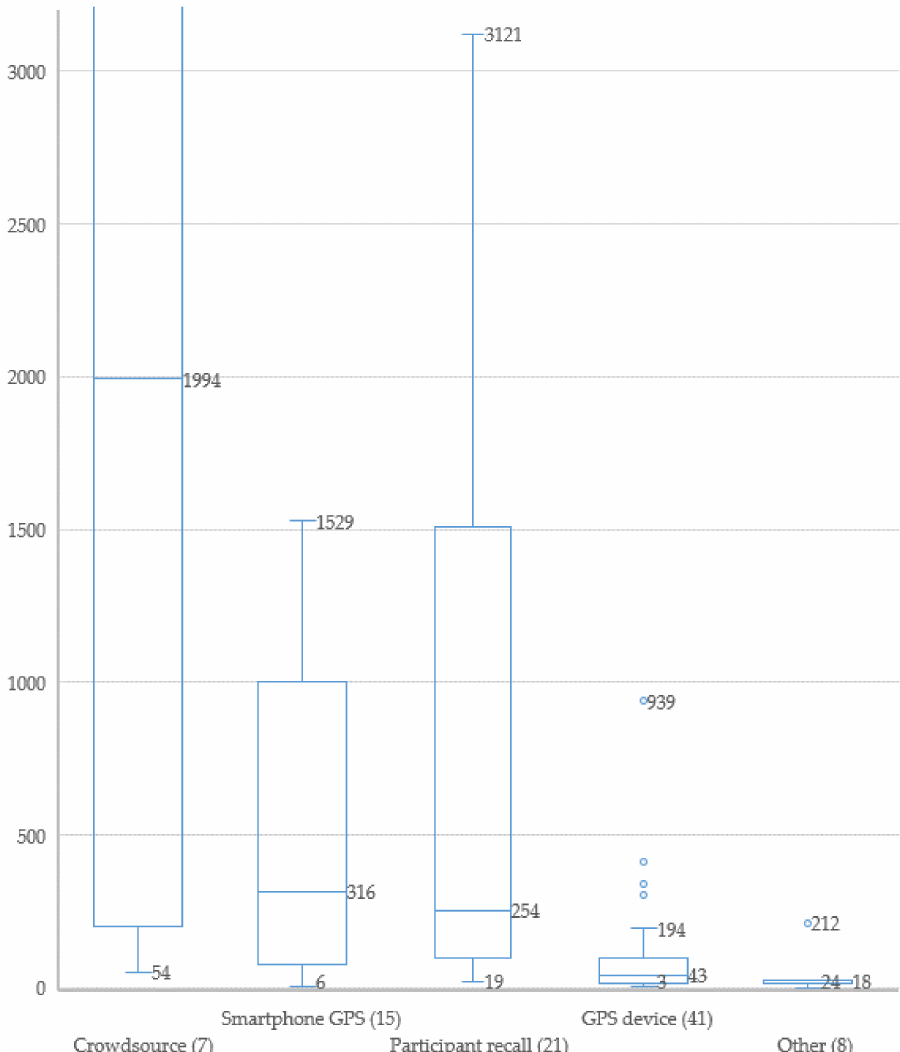
Figure 4. Reported number of participants by method family (number of included studies in parentheses). The category other includes accompanied trips, camera and